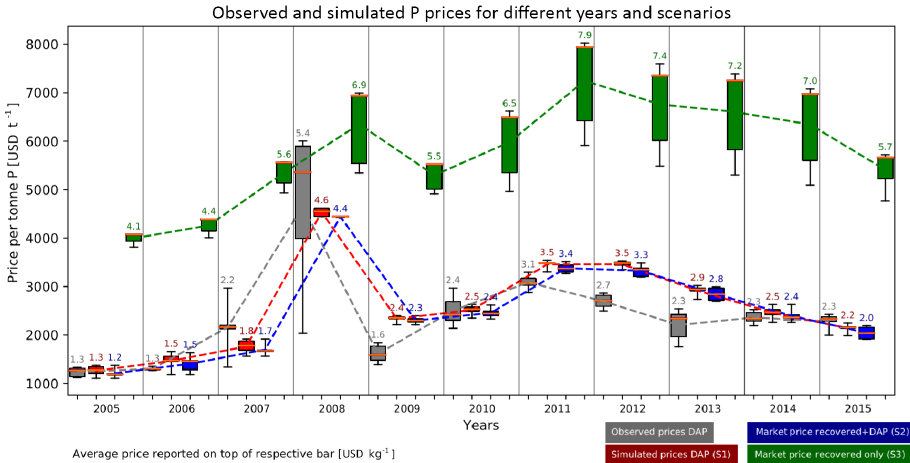
Figure 4. Plausible phosphorus price ranges at which trade can occur at global scale for different years: observed prices (grey) versus modelled scenarios (Sc. 1, pink; Sc. 2, blue; Sc. 3, green). The ends of the whiskers on the grey boxes for the observed prices represent the maximum and minimum prices for DAP that year, the box itself shows the upper and lower quartiles for that data, and the orange line indicates the median. For the modelled scenario the whisker-ends show the maximum and minimum prices as approximated by the model, the box indicates the most likely price range, and the orange line marks the most probable price given supply–demand ratios. Noticeable is that the model price determinations for the current mines-only scenario are in close proximity with observed price ranges. Scenario 2 and 3 are hypothetical scenarios and therefore do not have a realistic counterpart dataset that can be used for comparison. Nevertheless, they show predictable and realistic behaviour.